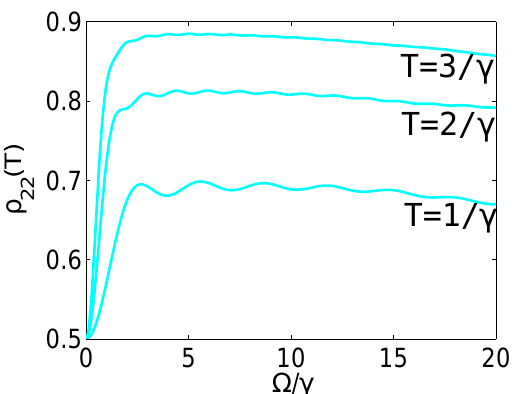
Figure 4. Final value ρ 22 ( T ) in the absence of the monolayer as a function of the Rabi frequency Ω , for various